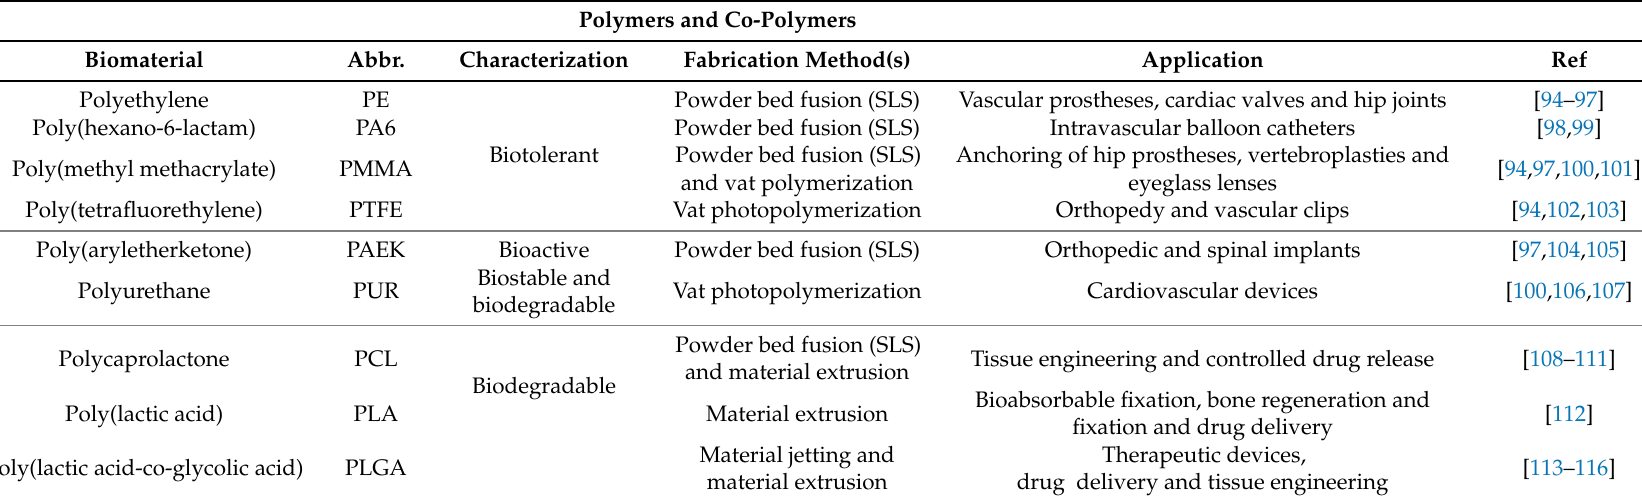
Table 2. Biocompatible polymers and co-polymers. The table gives an overview of biocompatible polymers and co-polymers, their characterization, applications, and additive manufacturing